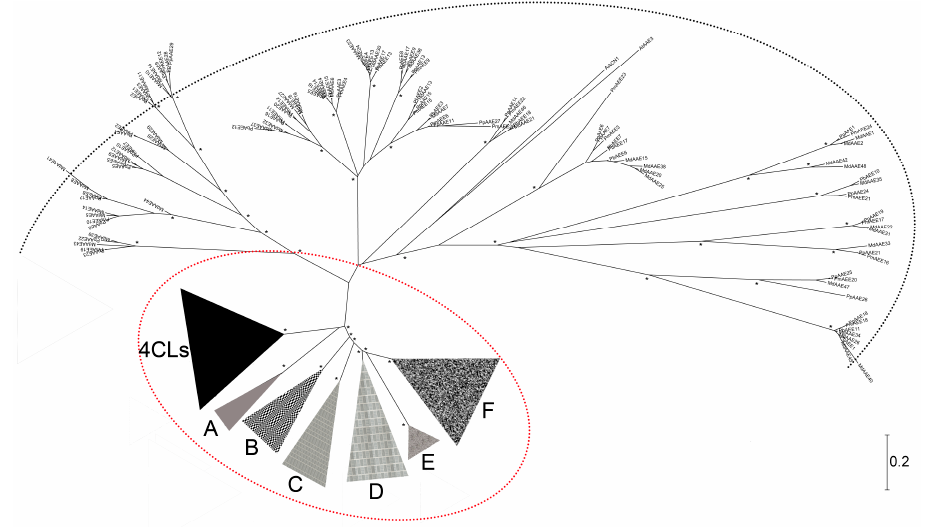
Figure 1. Phylogenetic relationships of 4-coumarate:coenzyme A ligase (4CL)-related proteins in Malus x domestica , Prunus persica , Prunus mume , Oryza sativa , Arabidopsis , and Pyrus bretschneideri . Asterisks represent bootstrap values of at least 70%. The large dashed arc indicates a large clade of acyl-activating enzymes (AAEs) from four Rosaceous plants ( Malus x domestica , Prunus persica , Prunus mume , and Pyrus bretschneideri ) as well as Oryza sativa and Arabidopsis . The red dashed ellipse indicates the clade of 4CL and acyl-coenzyme A synthetases (ACS) genes. The gene name species prefixes: Pb, Pyrus bretschneideri ; Pp, Prunus persica ; Pm, Prunus mume ; Md, Malus x domestica ; At, Arabidopsis thaliana ; and Os, Oryza sativa . Gene names and models are listed in Table 1 and Table S1. The scale represents 0.2 amino acid